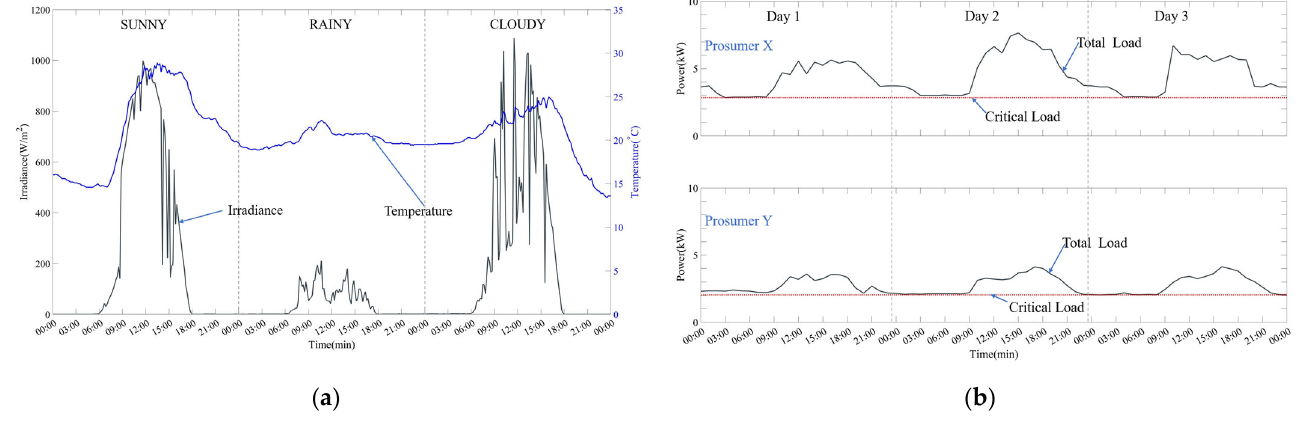
( b ) Figure 10. Test case 1 (disconnected). ( a ) Performance of prosumer X. ( b ) Performance of prosumer Y.